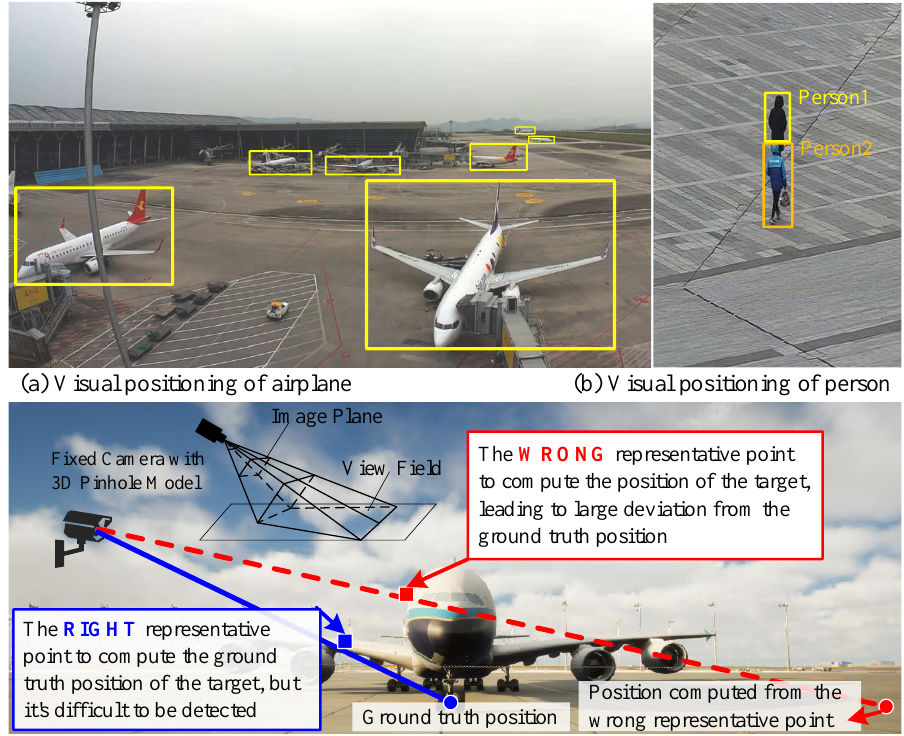
Figure 1. ( a , b ): The difficulty of choosing visual representative positioning feature points. ( c ): The occurrence of projection offset in traditional visual spatial positioning methods, produced by the pinhole-based 3D camera model if choosing a wrong representative positioning feature point, which is difficult to be overcome in existing visual positioning methods.